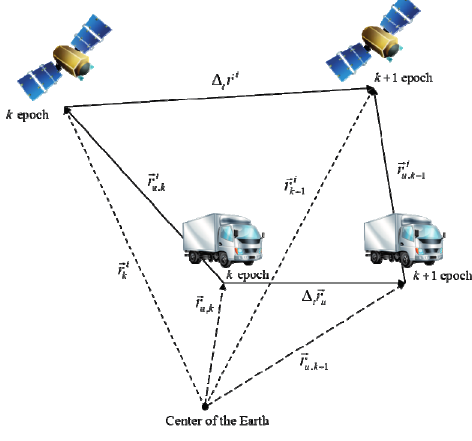
Figure 1. User and satellite configuration during consecutive GPS